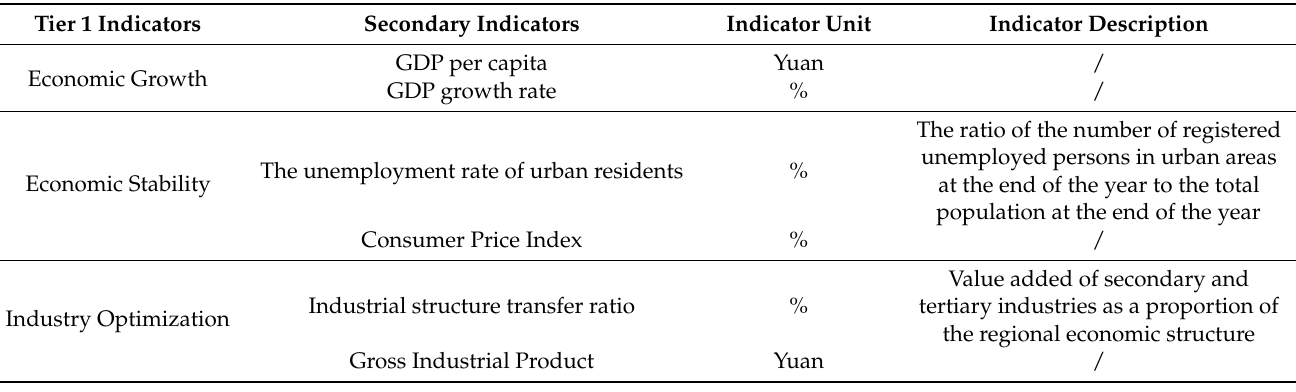
Table 10. System of indicators for measuring the regional